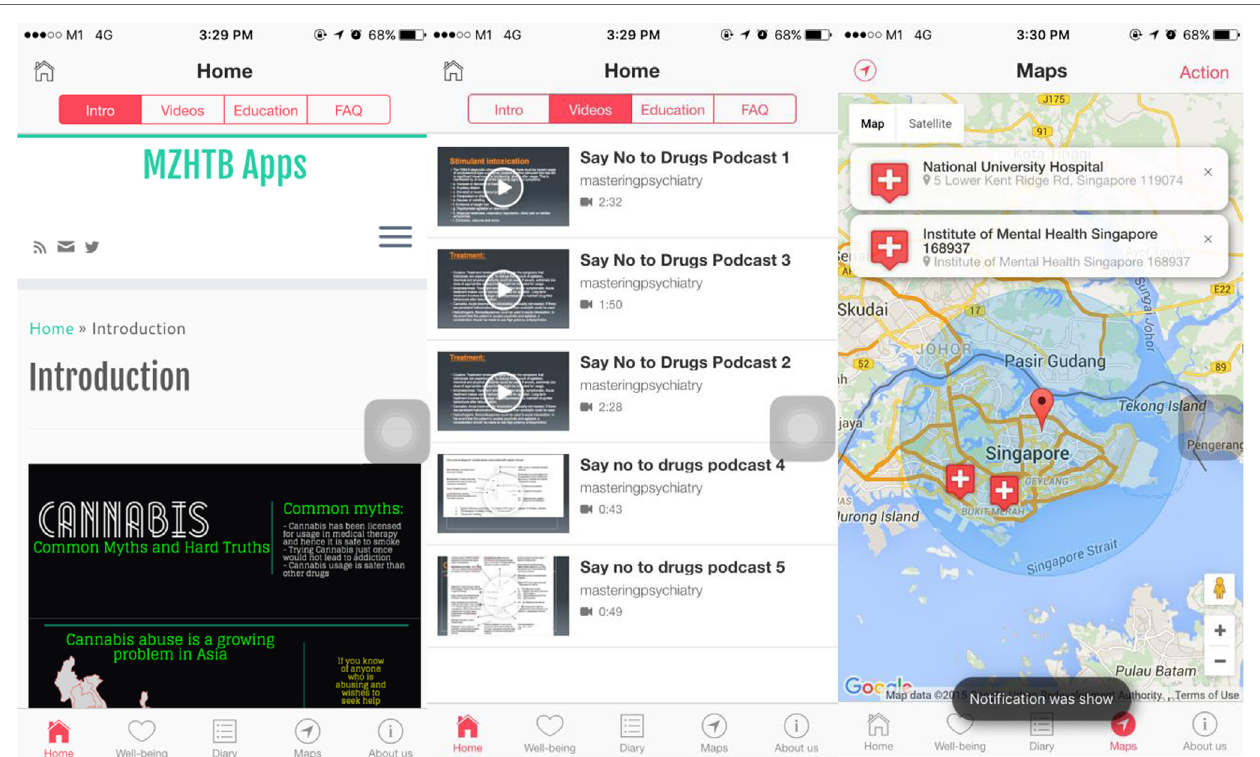
FiGUre 1 | Overview of the conceptualization of a Drug and substance Psycho-education Program